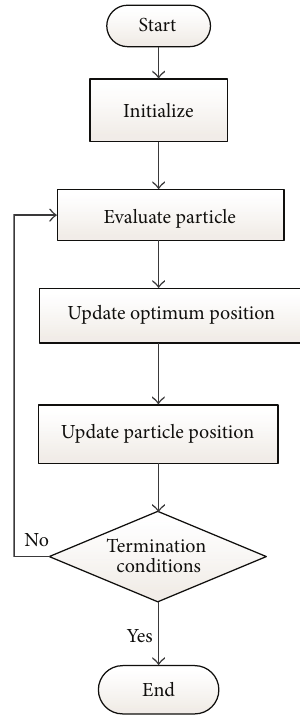
Figure 5: Particle swarm